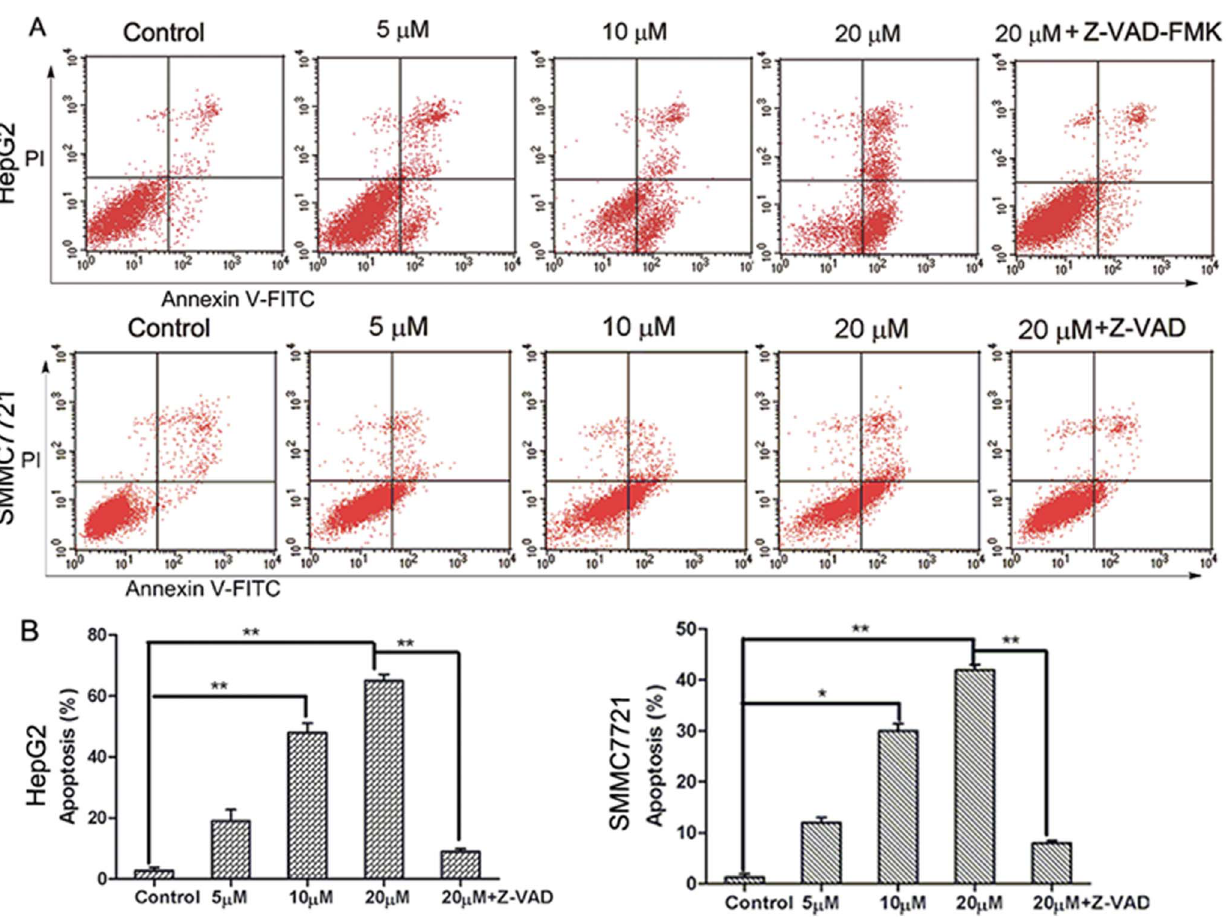
Fig. 2. Abieslactone-induced apoptosis in HepG2 and SMMC7721 cells. (A) Apoptosis was evaluated using an annexin V-FITC apoptosis detection kit and flow cytometry. The X- and Y-axes represent annexin V-FITC staining and PI, respectively. The representative pictures are from HepG2 and SMMC7721 cells incubated with different concentrations of abieslactone or caspase inhibitor (Z-VAD-FMK 20 m M). (B) Abieslactone induced apoptosis in HepG2 and SMMC7721 cells in a dose dependent manner. Z-VAD-FMK markedly reduced apoptosis in HepG2 and SMMC7721 cells treated with high-dose abieslactone. The data are expressed as the means ¡ SEM of three independent experiments with the similar results. * P , 0.05; ** P , 0.01 vs . the untreated